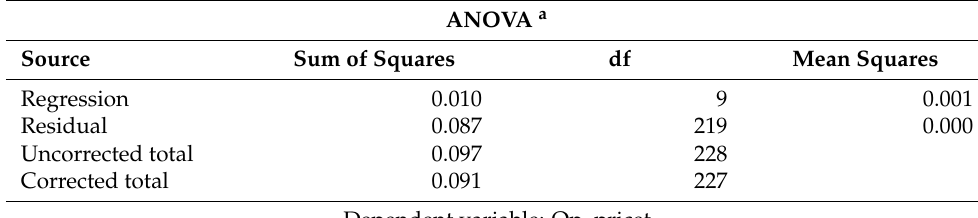
Table 7. ANOVA analysis for the